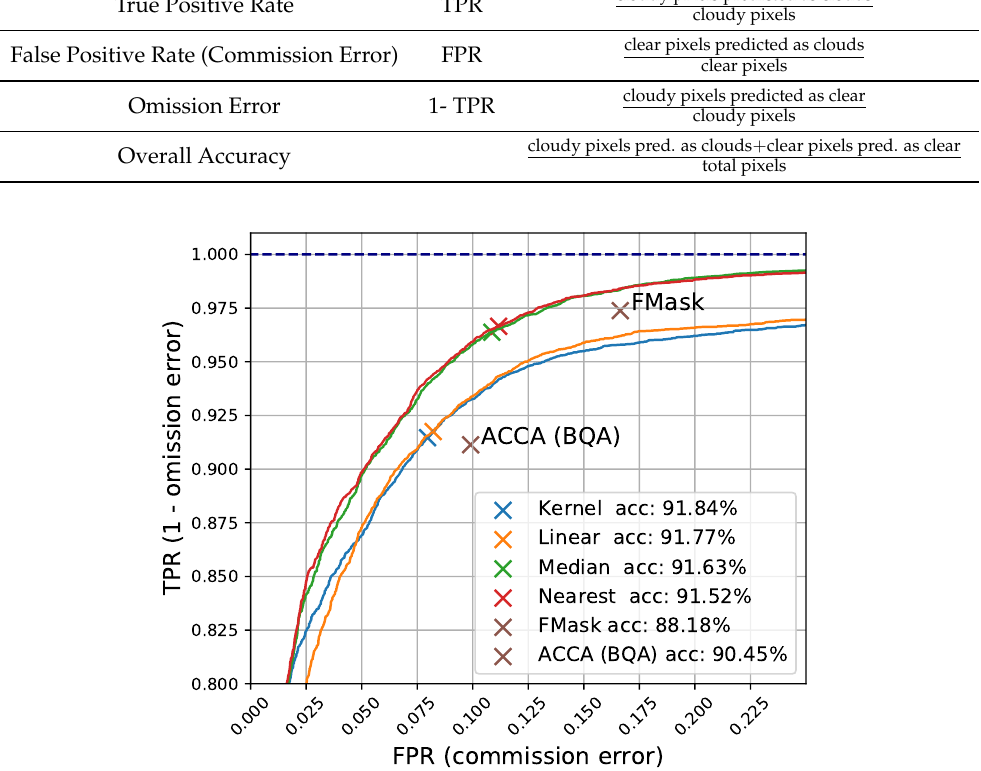
Table 1. Validation metrics: True Positive Rate (TPR), False Positive Rate (FPR), Commission Error, Omission Error, Overall Accuracy. True Positive Rate TPR